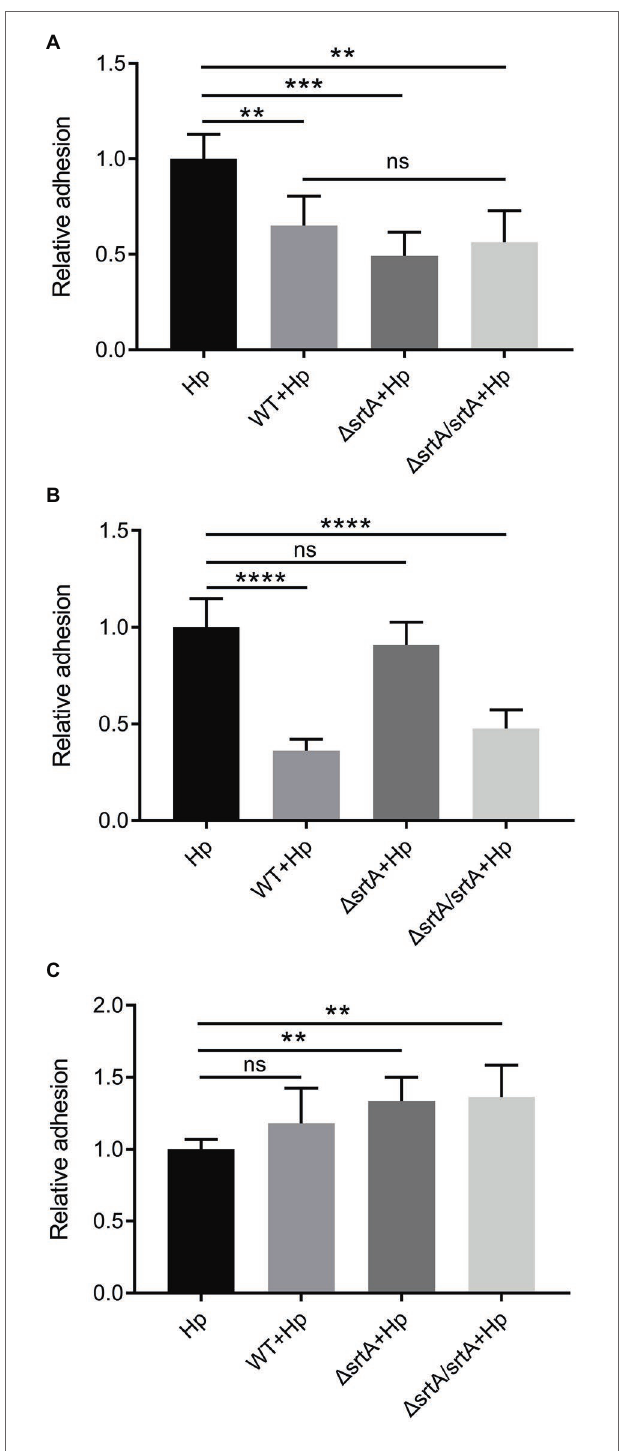
FIGURE 5 | Inhibition of H. pylori adhesion to human gastric epithelial cells by L. gasseri Kx110A1. Adherence of H. pylori 67:21 to AGS cells in (A) a competition assay, both strains added simultaneously; (B) exclusion assay, lactobacilli pre-adhered for 2 h, then H. pylori added; (C) replacement assay, H. pylori pre-adhered for 2 h, then lactobacilli added. Data represent the means ± SD of three independent experiments, ** p < 0.01, *** p < 0.001, **** p < 0.0001, ns, no